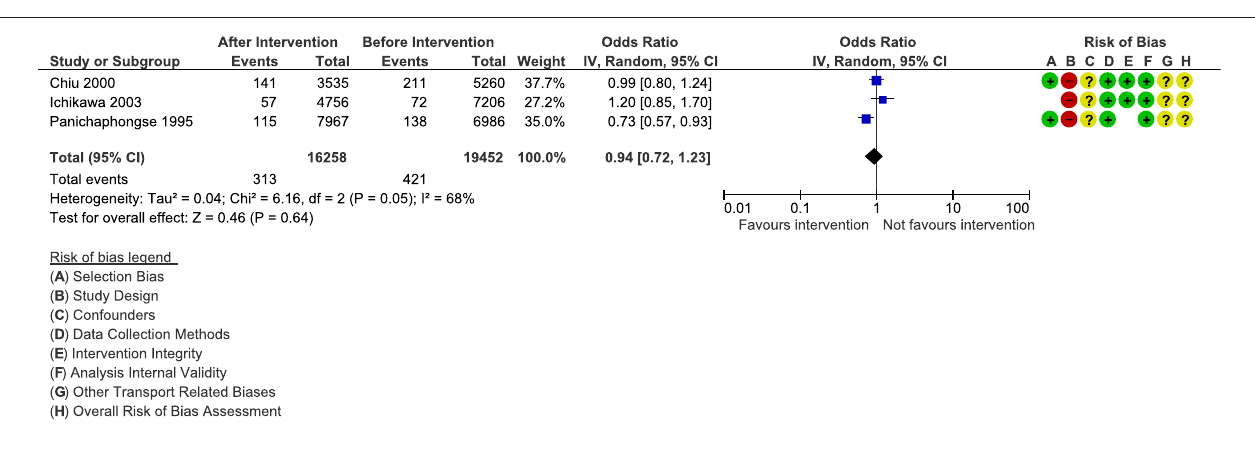
FIGURE 6 | Primary outcome: changes in ‘road traffic death counts’ after mandatory helmet law enforcement.